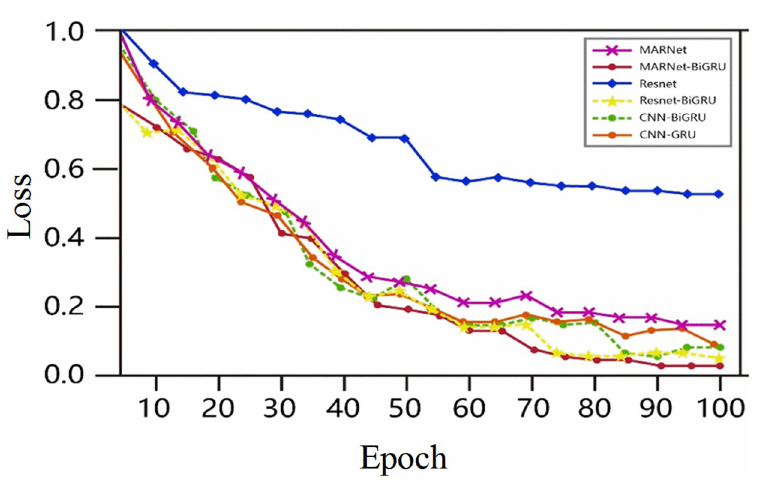
Fig 9. On the Sleep-EDF dataset, training loss values of six models.